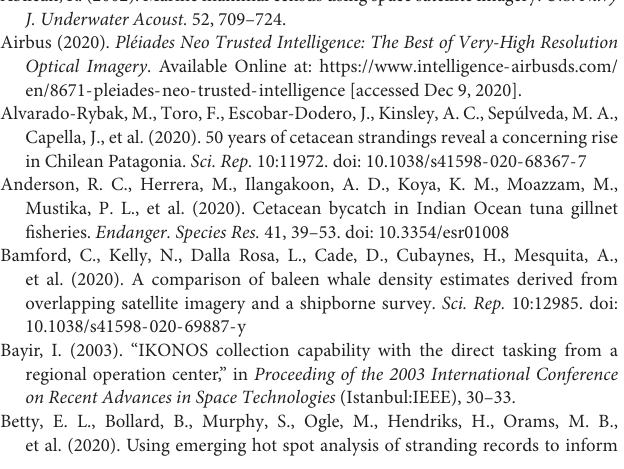
Supplementary Table 1 | Current list of operational and decommissioned VHR satellites, detailing ownership and the technical specification of each satellite. Supplementary Table 2 | List of baleen whale mass mortality events updated from Table 1 in Häussermann et al. (2017) an updated version of Table 1 in Rowntree et al. (2013). Data from this table is presented in a map in Figure 1(B). An asterix represents data that has been newly inputted or updated from the prior